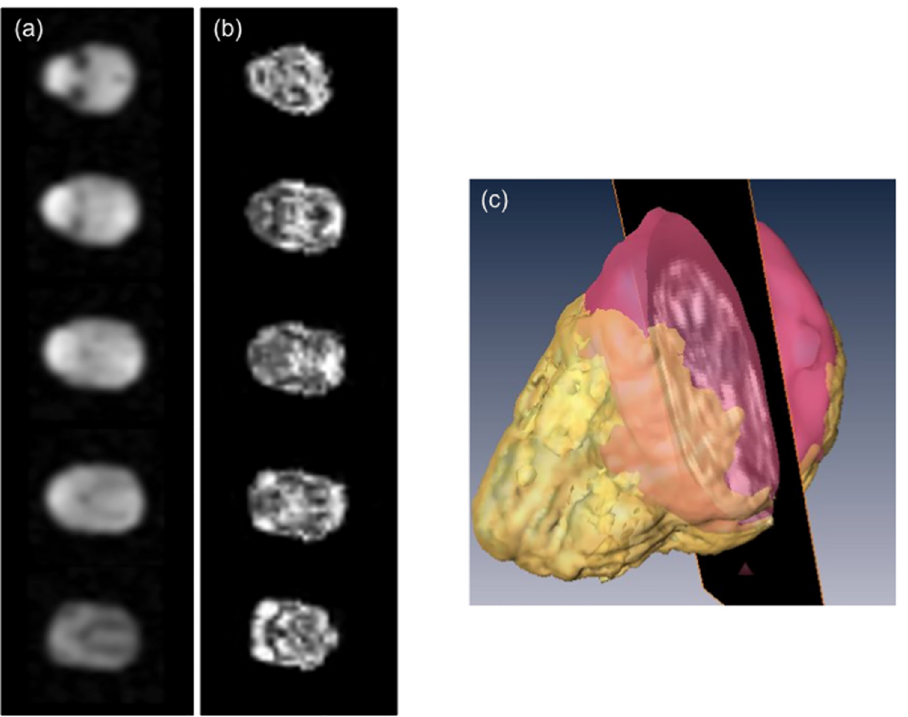
Fig 10. Slices from ex-vivo rabbit brain acquisition at 3x3x3 mm 3 spatial resolution. The slices compare (a) VLF-MRI (spin echo, T R = 500 ms, 32x32 phase encoding gradients, NEX = 16, T acq = 2.3 h) and (b) HF-MRI 3D T 1 -TFE (Ultrafast Gradient Echo) standard clinical sequence for brain anatomical characterization with 1x1x1 mm 3 resolution, 12x12x18 cm 3 FOV, T R = 8.5 ms, T E = 3.9 ms, NEX = 3 and T acq = 367 sec. The high field images are down sampled to match the low field resolution and spatially co-recorded. (c) The full 3D co-recorded volumes are shown with pink (VLF) and gold (HF) colors. Despite the lower resolution, VLF-MRI can be co-registered to the related HF-MRI.